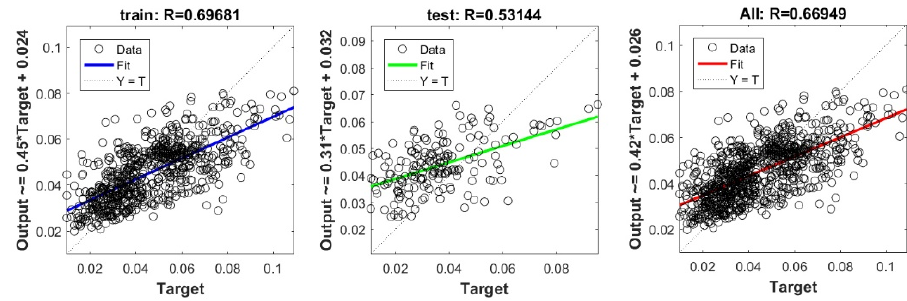
Figure A29. Scatter plots between target and output value by the PSO-Step model.